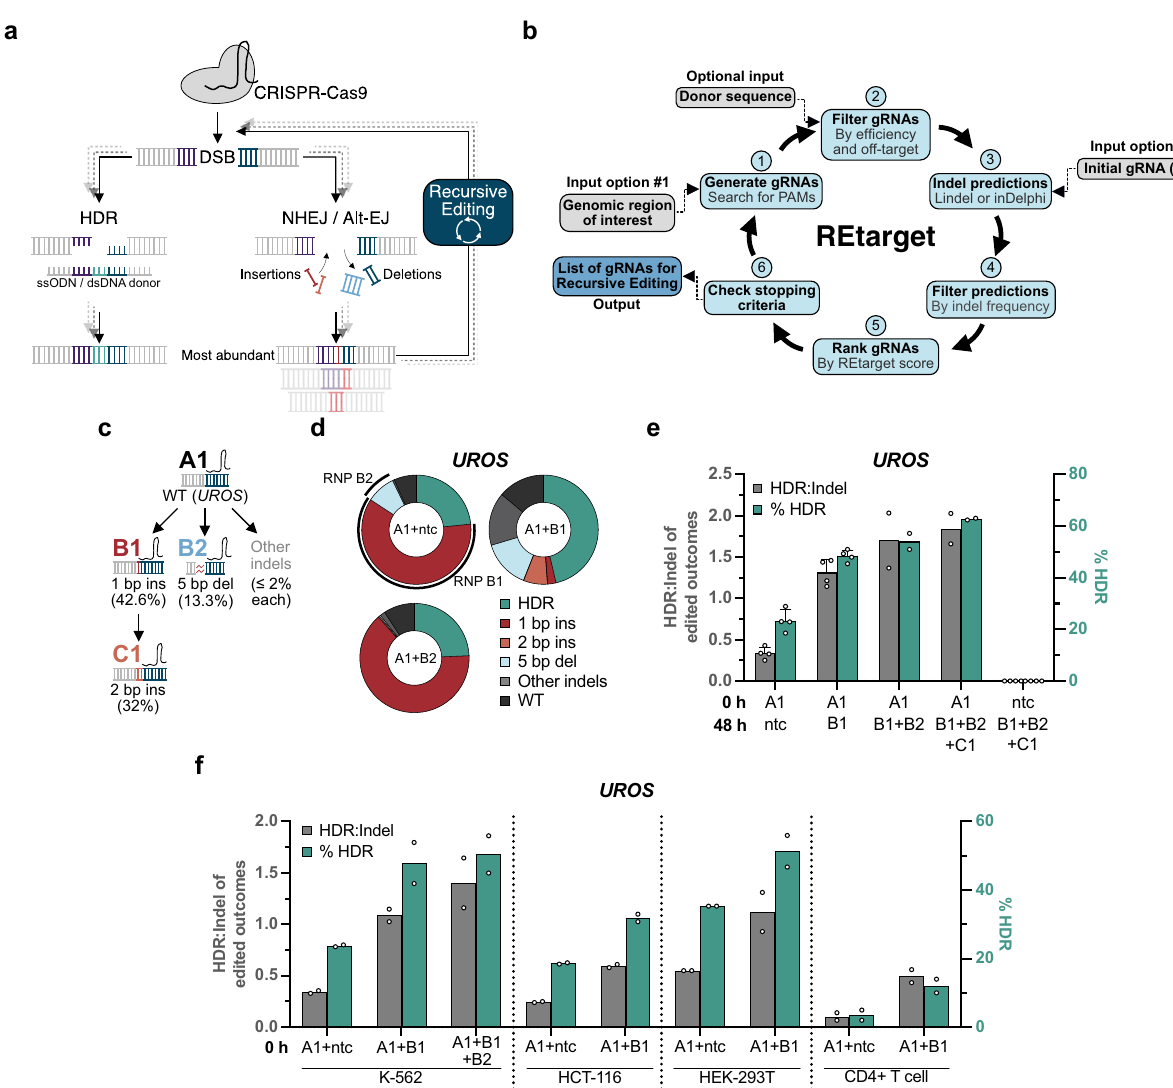
Fig. 1 Recursive Editing improves HDR by retargeting indel alleles. a A targeted DNA locus is recognized and cut by a Cas9-gRNA complex, creating a DSB. In addition to the desired HDR outcome, undesired indels of various identities are generated via DNA repair pathways like NHEJ and alt-EJ. Retargeting of abundant indels with a new Cas9-gRNA complex yields another opportunity for HDR while simultaneously reducing the number of indel alleles. This recursive strategy can be applied repeatedly. b Algorithmic overview of REtarget, a computational tool to fi nd genomic positions amenable for Recursive Editing and generate corresponding gRNAs. c Schematic output from REtarget for a given site within the UROS gene. gRNA A1 targets the wildtype allele which generates two predominant outcomes, targetable by gRNA B1 or B2. gRNA C1 targets an overall 2 bp insertion created by editing with B1. The listed percentages are the predicted abundance of the given outcome in the corresponding editing event as calculated by Lindel. d UROS -targeting RNPs complexed with the indicated gRNAs were delivered sequentially in K-562 cells at the indicated time points with an HDR donor that installs a 3 bp insertion. Data are displayed as a percentage of all alleles. e HDR:indel ratio on the left y-axis and the corresponding HDR frequency on the right y-axis for sequentially delivered RNPs targeting UROS in K-562 cells. f Recursive Editing remains effective when all RNPs are simultaneously delivered in a single electroporation ( t = 0 h) in diverse cell types. Each data point in d – f represents an individual biological replicate ( n = 2 – 4). Error bars + / − standard deviation (SD). Abbreviations: ins insertion, del deletion, ntc nontargeting control, indels insertions and deletions, WT wildtype. Source data are provided as a Source Data fi detectable editing. Overall, targeting UROS illustrates the poten- delivery (50.4 ± 7.7 %) was lower than with sequential delivery tial of converting indels to HDR outcomes with Recursive Editing (62.7 ± 0.4 %). Blocking of the initial target site by co-delivered to increase HDR. RNPs could contribute to this effect, even though we did not detect any editing with RNPs B1 B2 C1 (Fig. 1e). Reduced HDR adds additional steps to genome editing work fl ows. We therefore with simultaneously delivered reagents could also be related to explored whether simultaneous delivery of multiple RNPs in a the degradation of RNP and/or ssODN over time. However, single electroporation could drive Recursive Editing. Co-delivery neither phosphorothioate-protected ssODNs nor multiply- of three RNPs at once (A1 B1 B2) resulted in an improved protected synthetic gRNAs yielded a discernible change in editing HDR:indel ratio of 1.4 compared to 0.34 with only RNP A1 outcomes (Supplementary Fig. 2). As a precaution, we utilized (Fig. 1f). The maximal HDR frequency from simultaneous protected ssODNs for subsequent experiments.